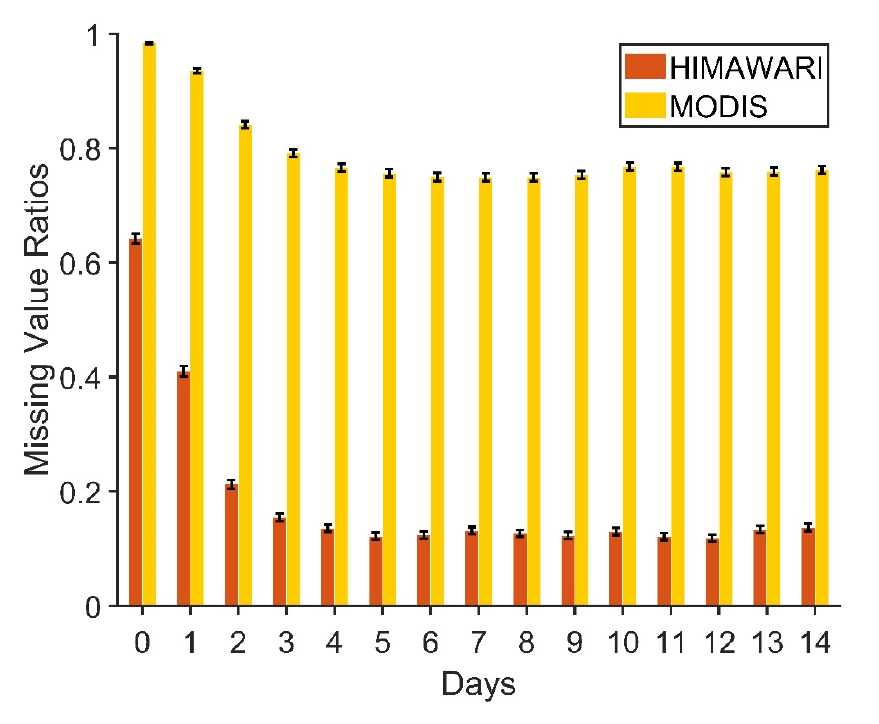
Figure 3. Characteristics of the ratios of missing values of Himawari-8 AHI images (bars in orange) and MODIS images (bars in yellow). The error bars represent the 95% confidence intervals from the mean values on different days for the two datasets.